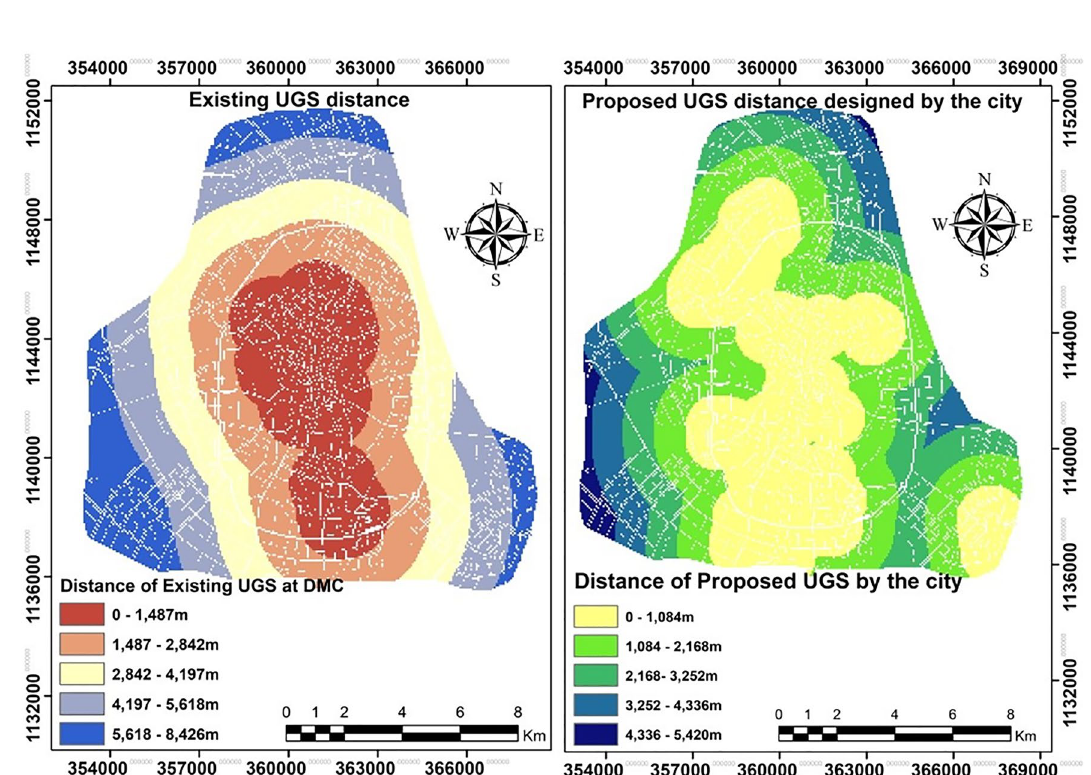
Fig. 12 Existing and Proposed UGS